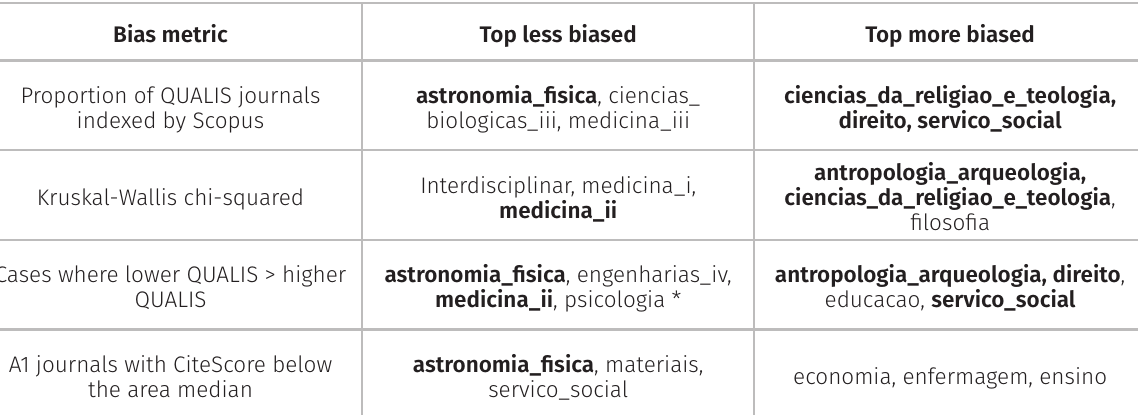
Figure 2. Number of journals not indexed by Scopus, indexed with available CiteScore 2017, and indexed without CiteScore 2017, across all 49 QUALIS subject areas. Original QUALIS subject area names are shown (as written in their respective classification sheets) but their English translation can be found in Table SI. Subject areas are sorted by the proportion of QUALIS journals indexed by Scopus. Table II. Top less and more biased subject areas according to four bias metrics (see methods for details). Each group is composed of the lower (5% quantile) or upper (95% quantile) subject areas. Subject areas in bold were ranked in these quantiles using more than one bias metric. Original QUALIS subject area names are shown (as written in their respective classification sheets) but their English translation can be found in Table